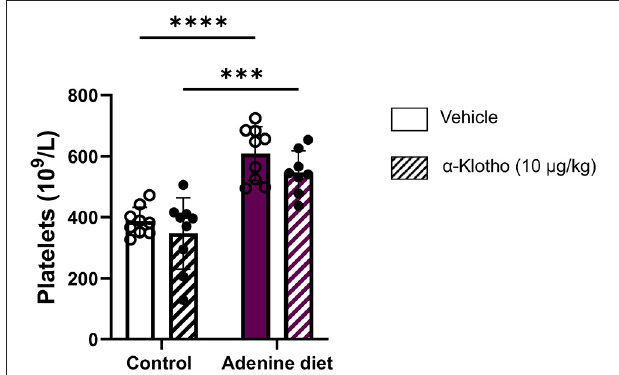
FIGURE 7 | Effect of adenine diet and Klotho administration on platelets. C57BL/6J male mice fed control or 0.2% adenine diet for 8 weeks were administered with either saline or mouse recombinant Klotho protein (10 µ g/kg) 24h before sacrifice. Whole blood was collected and platelet concentration was quantified using Hematology Analyzer. Data are represented as mean ± SD ( n = 8–9 per group). *** P < 0.001, **** P < 0.0001 compared to Control.